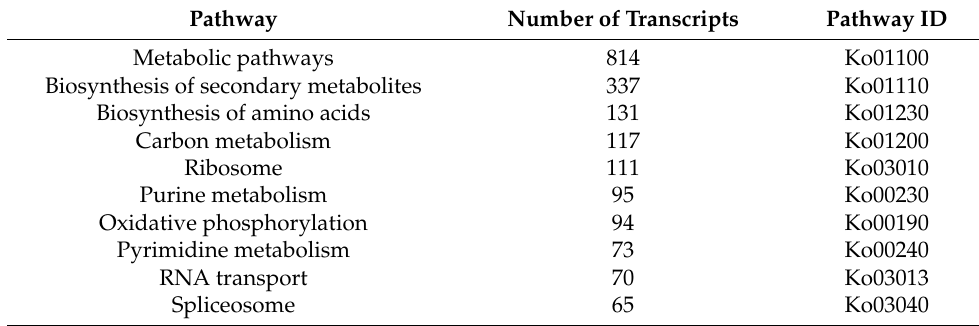
Figure 2. Gene Ontology (GO) annotation of non-redundant transcripts of Kappaphycus alvarezii . All the transcripts were grouped into three major functional categories, as indicated. Table 1. The top ten pathways identified in the Kappaphycus alvarezii